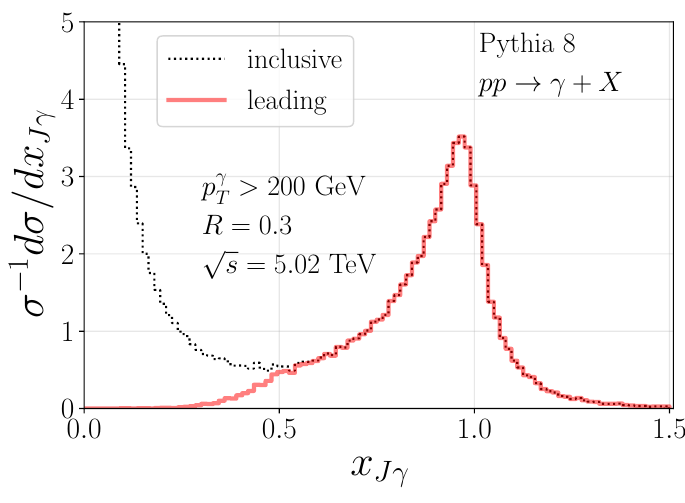
Figure 19 . The x Jγ distribution for inclusive and leading jets recoiling against a direct photon with large transverse momentum in proton-proton collisions at here is obtained from Pythia 8